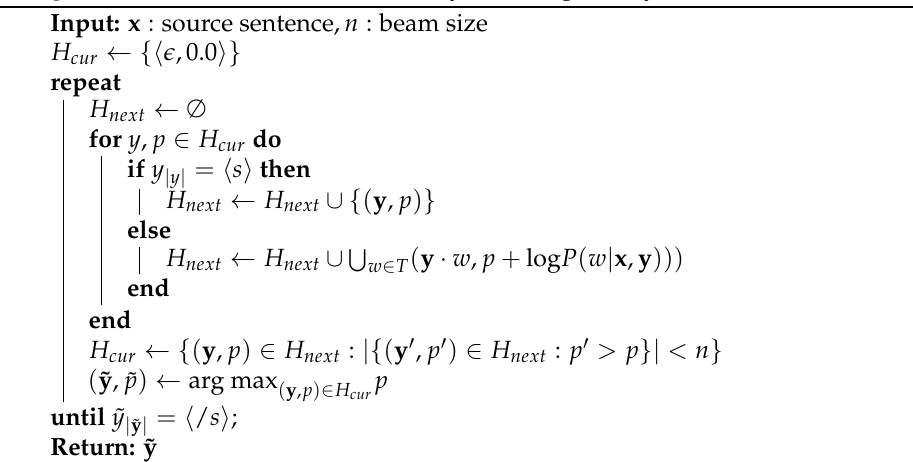
Algorithm 3: Beam search as defined by Stahlberg and Byrne